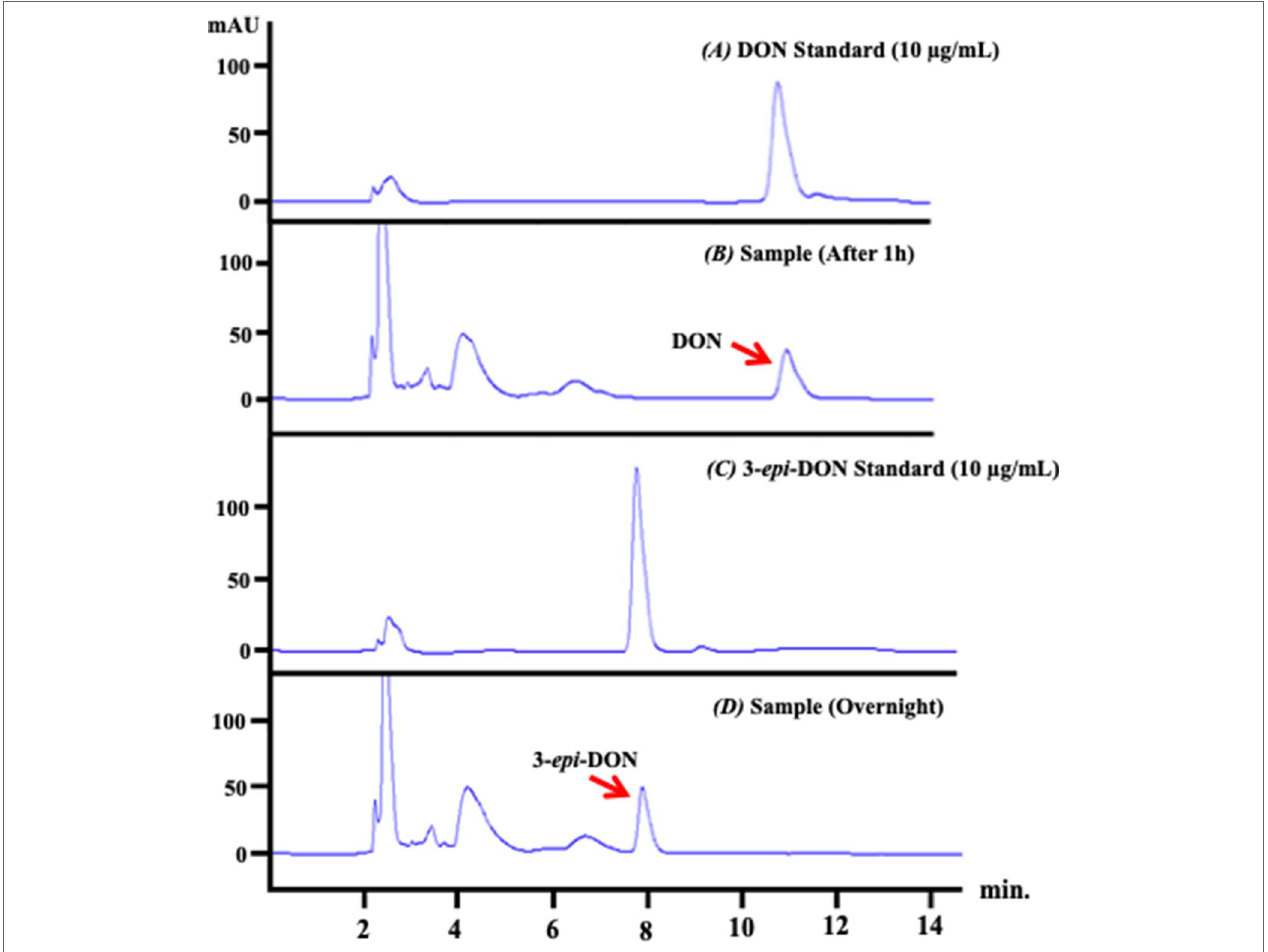
FIGURE 3 | D. mutans 17-2-E-8 ability to biotransform DON. The obtained high-performance liquid chromatography results of overnight bacterial culture samples confirmed the ability of D. mutans 17-2-E-8 to epimerize DON and form the 3- epi -DON stereoisomer. The bacterial culture was utilized directly for total RNA preparation. Panel (A) represents DON standard in LB broth while panel (B) represents the fresh bacterial culture supplemented with DON (50 µg/ml) after one hour of growth. Panel (C) reflects the chromatogram of 3-epi-DON standard in fresh LB broth while the (D) panel shows the depleted bacterial culture after an overnight incubation with DON confirming DON disappearance and complete transformation into 3- epi